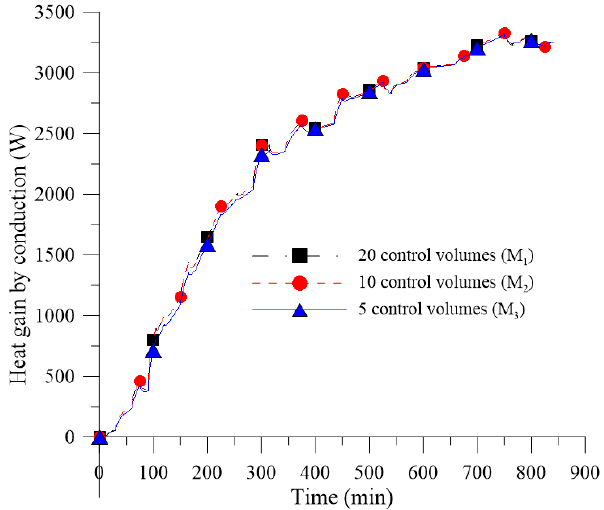
ff erent meshes. Energies 2019 , 12 , x FOR PEER REVIEW 19 of 30